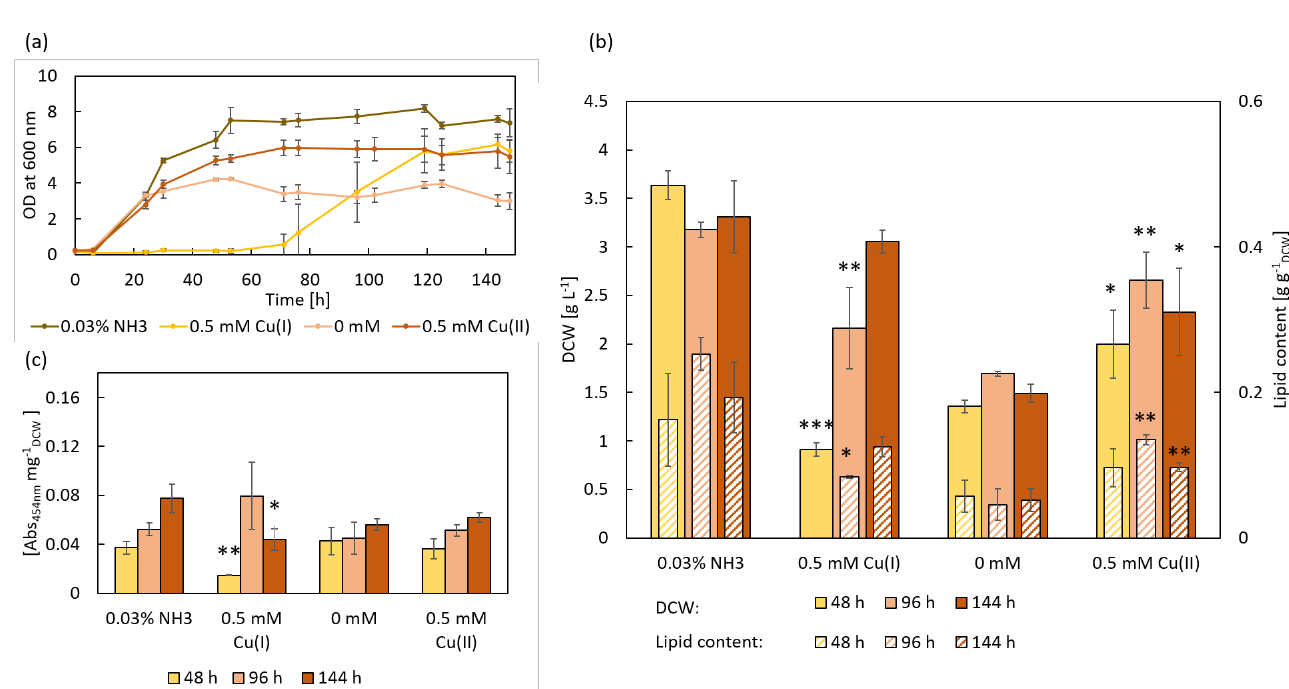
Figure 3. Growth, lipid, and carotenoid accumulation of R. toruloides IFO0880 supplemented with 0.5 mM of Cu(I) and Cu(II), as well as respective control, whereas NH 3 served as control for Cu(I)- treated samples and 0 mM served as control for Cu(II)-treated samples. * p < 0.05, ** p < 0.01, *** p < 0.001 ( t -test always evaluated against respective control), n = 3. ( a ) Growth measured as OD at 600 nm over 144 h. ( b ) Biomass formation (DCW) and lipid content (normalized to DCW) at 48, 96, and 144 h. No lipid content was determined for 0.5 mM Cu(I) at 48 h, as not enough biomass had accumulated at this time point. ( c ) Carotenoid accumulation (normalized to DCW) at 48, 96, and 144 h.